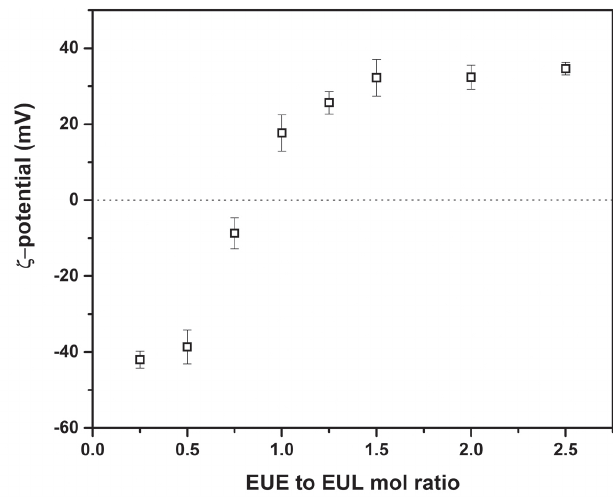
FIGURE 1 - Variation of ξ-potential as a function of IPEC